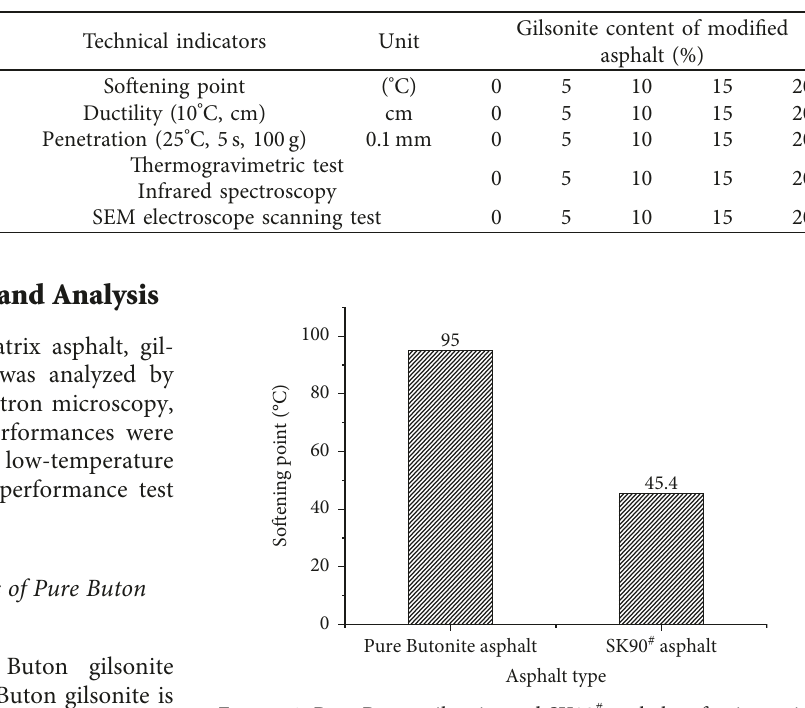
Table 2: Experimental design of modified asphalt with different gilsonite contents.